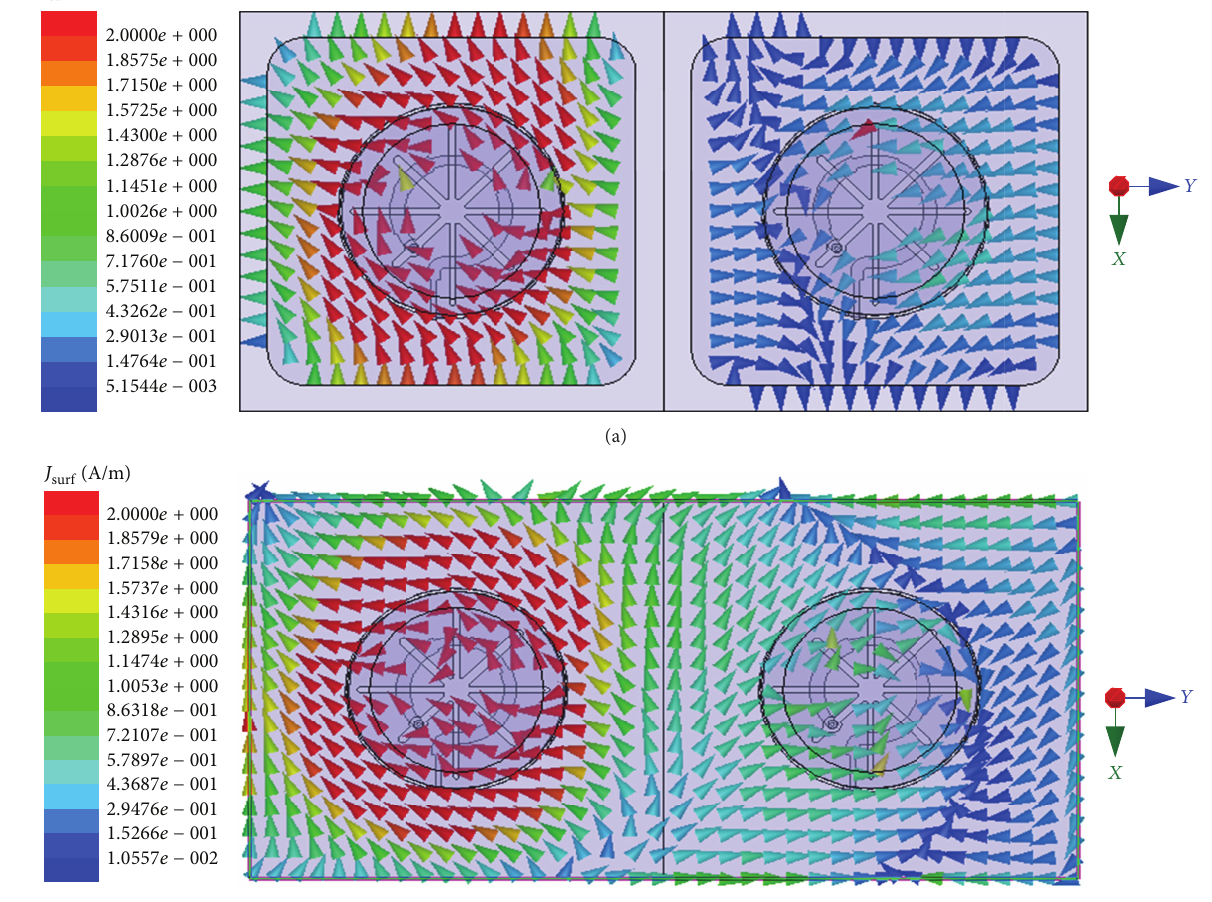
Figure 5: The simulated current distribution on the ground of the antenna array at the centre frequency of 3.7 GHz. (a) With side wall. (b) Without side